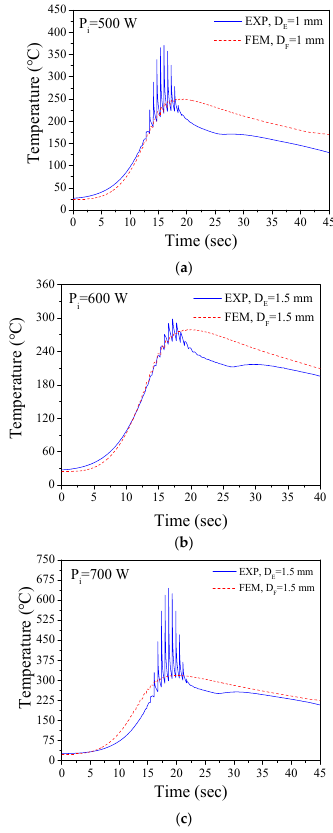
Figure 8. Numerical comparisons between FEA and experimental results for the temperature. ( a ) 500 W, ( b ) 600 W, and ( c ) 700 W With the extended cycloidal path of the laser spot, the residual stress prediction in the laser-hardened zone is shown in Figure 9. In the figure, the laser power had a value of 500 W. The extended cycloidal movement had a linear speed of 100 mm/min and a rota- tional speed of 100 rpm. According to the simulation, the normal stress with the normal as the X-axial direction was compressive and had a value of 402.1 MPa. Using the PULSTEC μ -X360n diffractometer (Pulstec Industrial Co., Ltd., Hamamatsu, Japan), the residual stresses measured had a normal stress of − 424 MPa and a shear stress of − 30 MPa, as shown in Figure 10.